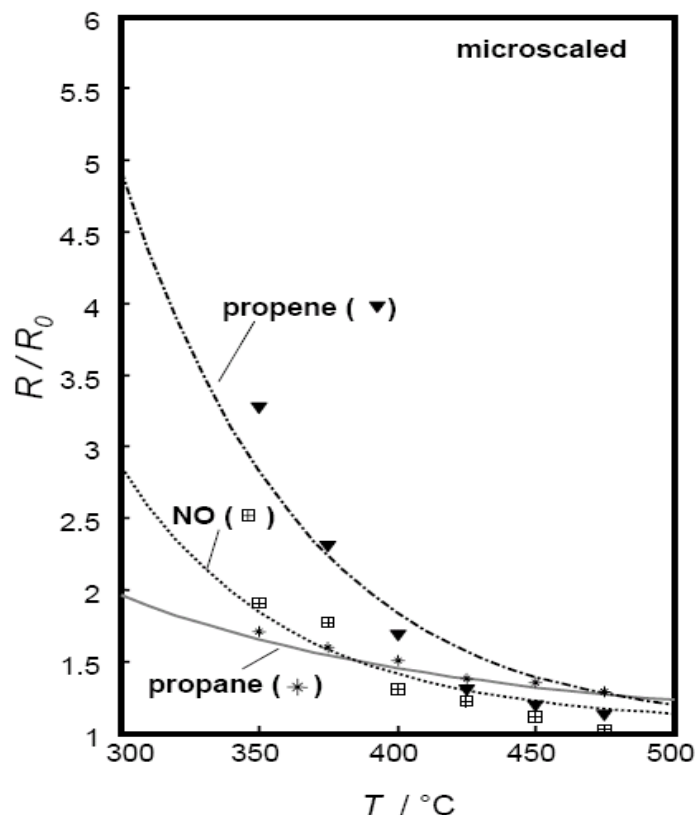
Figure 7. Calculated and measured propane, propene, and NO response of a Fe O microscaled sensor thick film as a function of temperature, film thickness SrTi 0.8 0.2 3- d t = 16.7 film